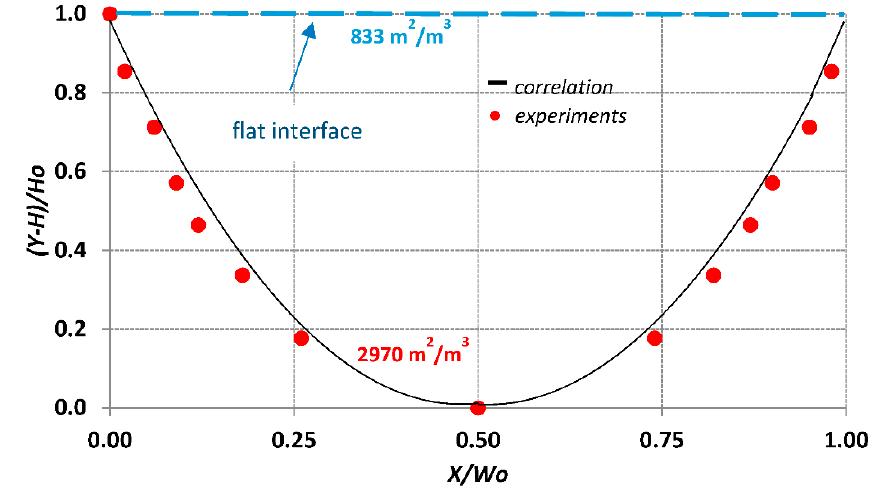
Figure 15. Comparison of specific surface between the flat interface and the meniscus shape calculated by the proposed correlation Equation (6) for nW , 40 mL/h, 25°.